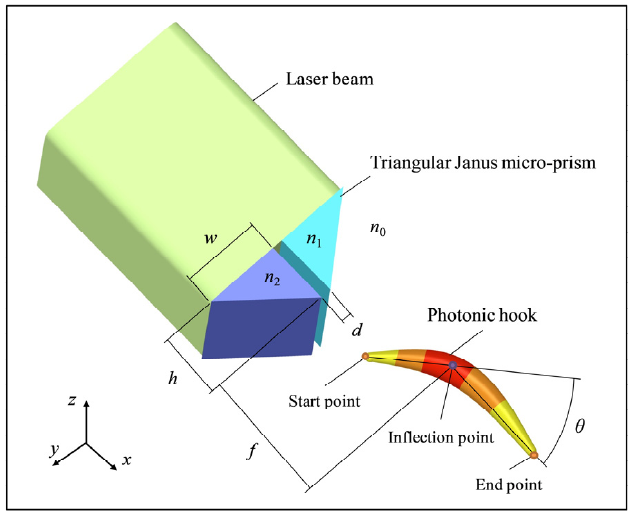
Figure 1. Schematic stereogram of the triangular Janus micro-prism for photonic hook.